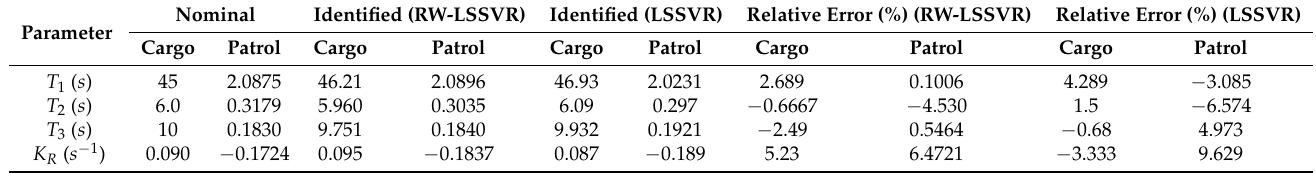
Table 5. Identification results of the linear response model for vessels.